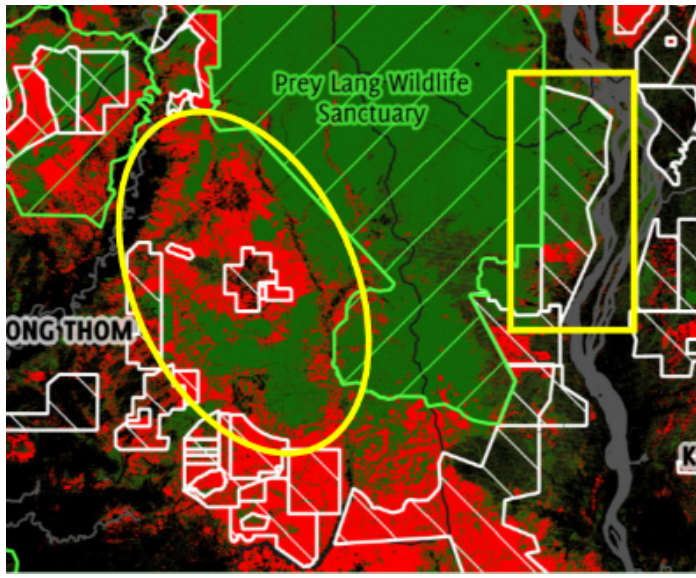
Figure 3. Tumring REDD+ Project (T-REDD) circled (project area is green); Think Biotech Cambodia, co. ltd. (TB, Phnom Penh, Cambodia) squared.